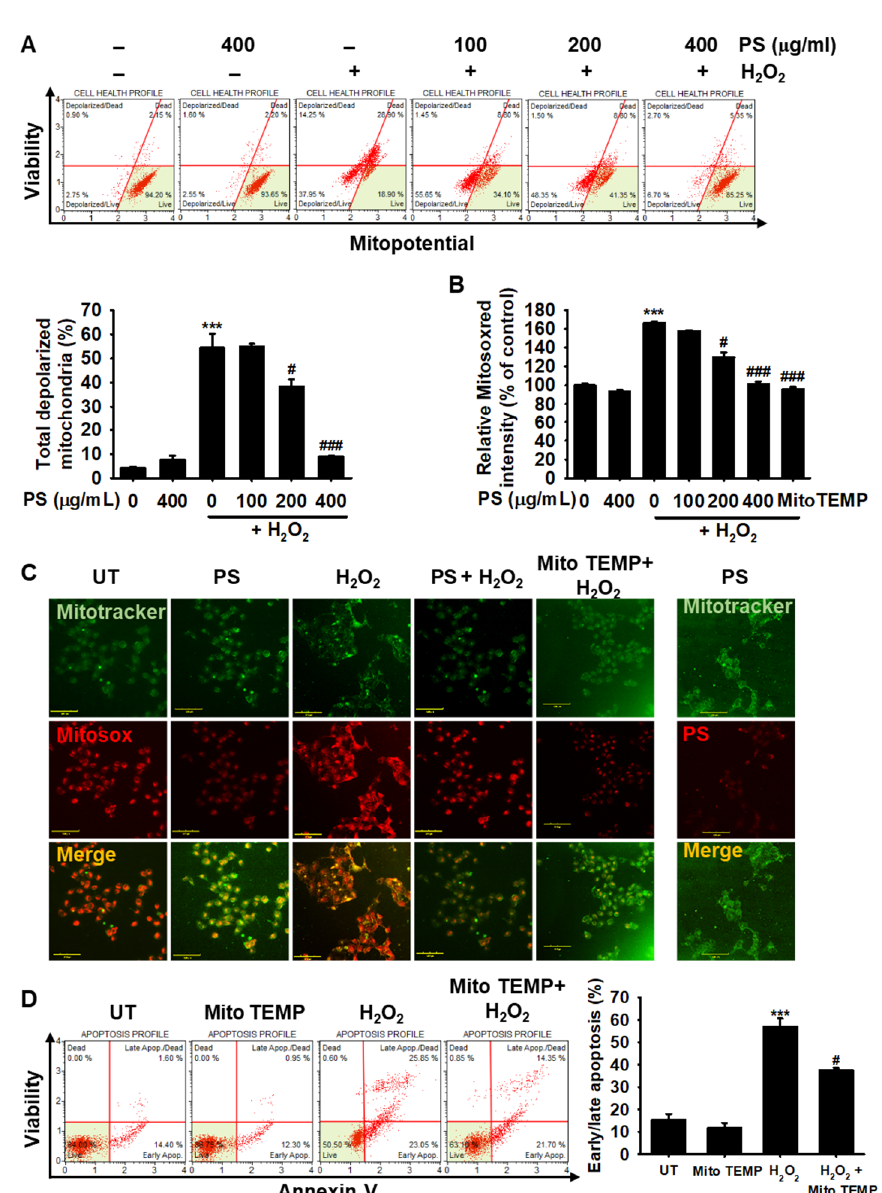
Figure 5. PS inhibits H 2 O 2 -induced mitochondrial membrane depolarization and mtROS-mediated apoptosis in HaCaT keratinocytes. HaCaT keratinocytes were seeded at a density of 1 × 10 4 cells/mL and treated with the indicated concentrations of PS (0–400 μg/mL) in the presence or absence of 1000 μM H 2 O 2 for 4 h. MitoTEMP (10 μM) was used as the negative control. ( A ) The cells were stained with Muse ® MitoPotential Kit and mitochondrial membrane depolarization was analyzed by flow cytometry. The mean percentages of depolarized mitochondrial populations are shown in the bar graphs. ( B ) The cells were also stained with 2 μM MitoSOX Red and the fluorescence intensity was measured by using a fluorometer. Percentage values were calculated compared to that in the untreated group. ( C ) The cells were stained with 0.5 μM MitoTracker for 30 min followed by 2 μM MitoSOX Red for 10 min. Immunofluorescence staining was performed and detected by using the CELENA ® S digital imaging system. ( D ) In a parallel experiment, the cells were pretreated with 10 μM MitoTEMP prior to stimulation with H 2 O 2 for 4 h. The populations of early/late apoptosis populations were measured by flow cytometry using Muse ® Annexin V and Dead Kit. Early/late apoptotic populations are shown in the bar graph. All data are averaged from three independent experiments and presented as mean ± the standard error of the median [*** p < 0.001 vs. the untreated group (UT) and ### p < 0.001 and # p < 0.05 vs. the H 2 O 2 -treated group]. Scale bars = 100 μm.